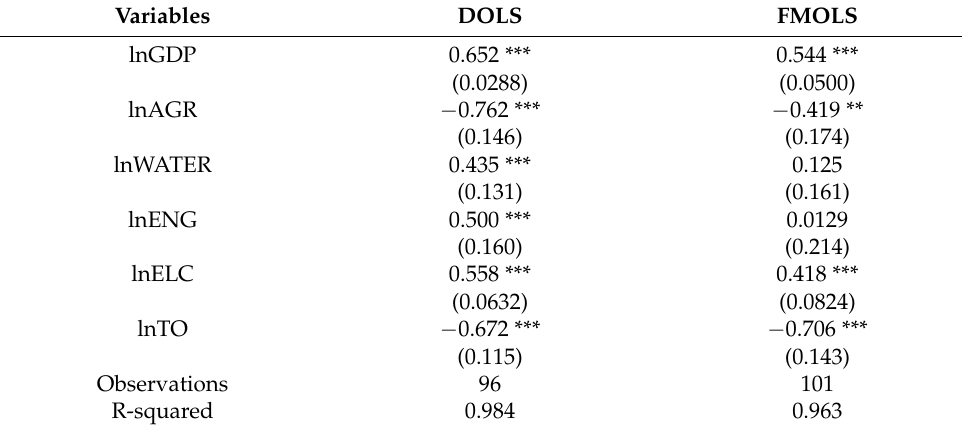
Table 6. Panel FMOLS and DOLS models estimation results.